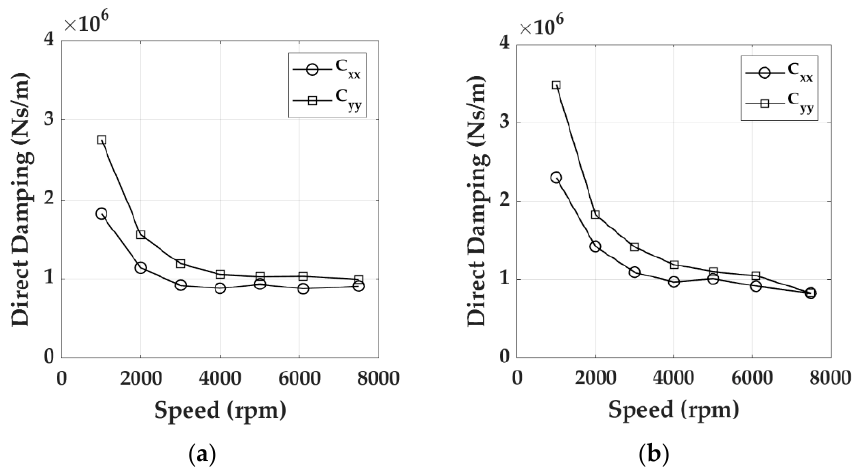
Figure 33. Direct Lube Rocker Pivot bearing synchronous direct damping: ( a ) 0.8 MPa, ( b ) 1.7 MPa.